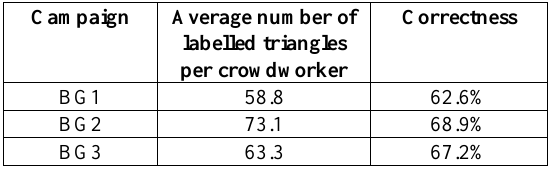
Table 7 . Results of labelling with gamification in study B.